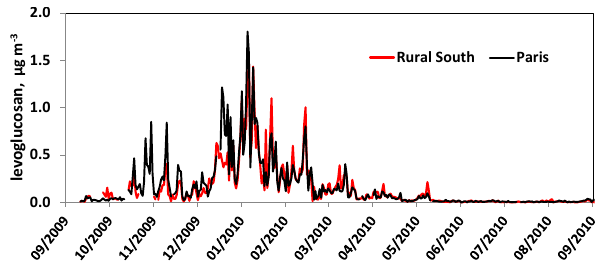
Figure 8. Contributions to secondary organic aerosol during the MEGAPOLI summer campaign period, simulated with the CHIMERE model: BGOA (background organic aerosol), BSOA (biogenic SOA), ASOA (anthropogenic SOA), OPOA (oxidized pri- mary OA of anthropogenic origin). BSOA and BGOA are consid- ered as of non-fossil fuel, ASOA and OPOA as of fossil fuel origin.